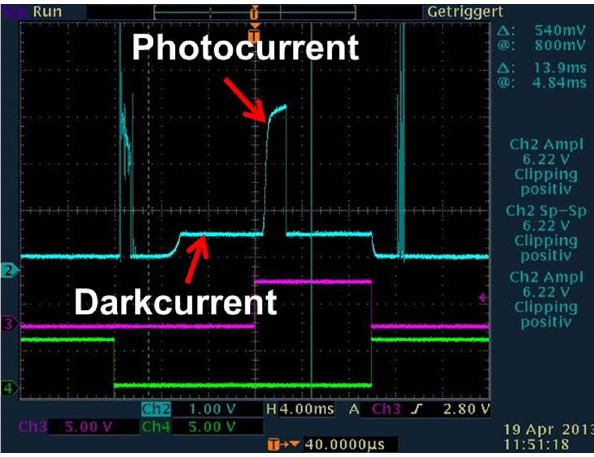
FIG. 5. Dark current from the gun without any cathode and with ¼ 16 . 2 MV = m. The different photocathodes vs axis peak field. The red dots are from a FIG. 4. Display on oscilloscope, E z: max measurement with a Pb-coated Nb cathode. Pink triangles blue line (top) gives out the Faraday cup signal of the sum of the represent the case with uncoated Mo cathode. The hollow squares dark current and the photocurrent; the green line (bottom) shows and the green balls are with Cs 2 Te emission layer on Mo the macropulse signal of the solid state amplifier; and the magenta line (middle) represents the trigger signal of the cathode substratum. The blue squares give the result of the case without drive laser. cathode